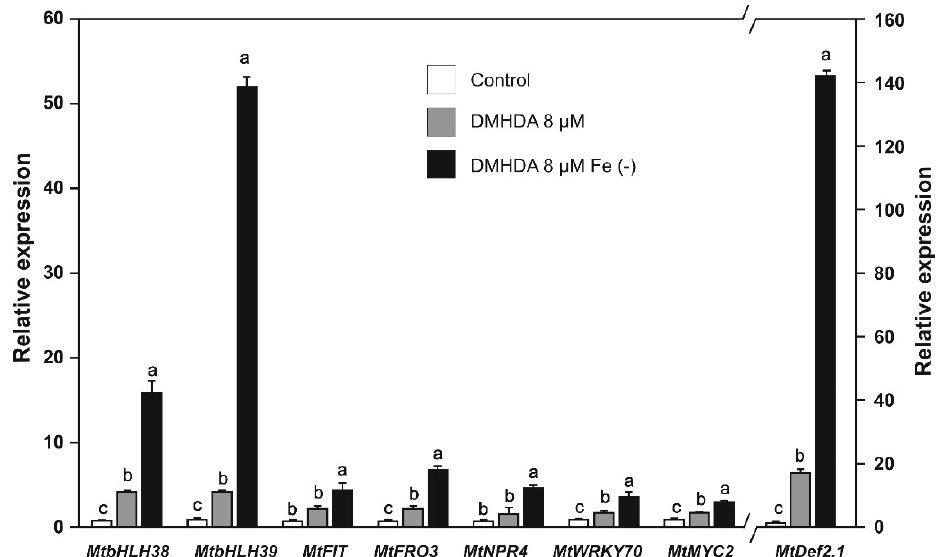
Figure 8. Relative expression of iron uptake and defense genes in Medicago truncatula plants grown with DMHDA (8 μ M) under both iron-sufficient and iron-deficient conditions for 48 h. Values represent mean ± standard errors of relative expression in reference to controls. Values of MtDef2.1 expression are referred to secondary axis. Different lowercase letters indicate significant differences as determined by one-way ANOVA and Tukey’s test ( p < 0.5; n = 3).